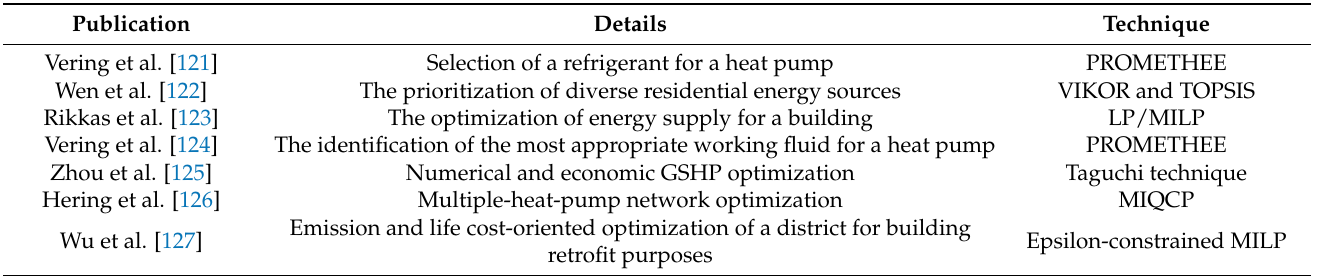
Table 1. A sample of the related